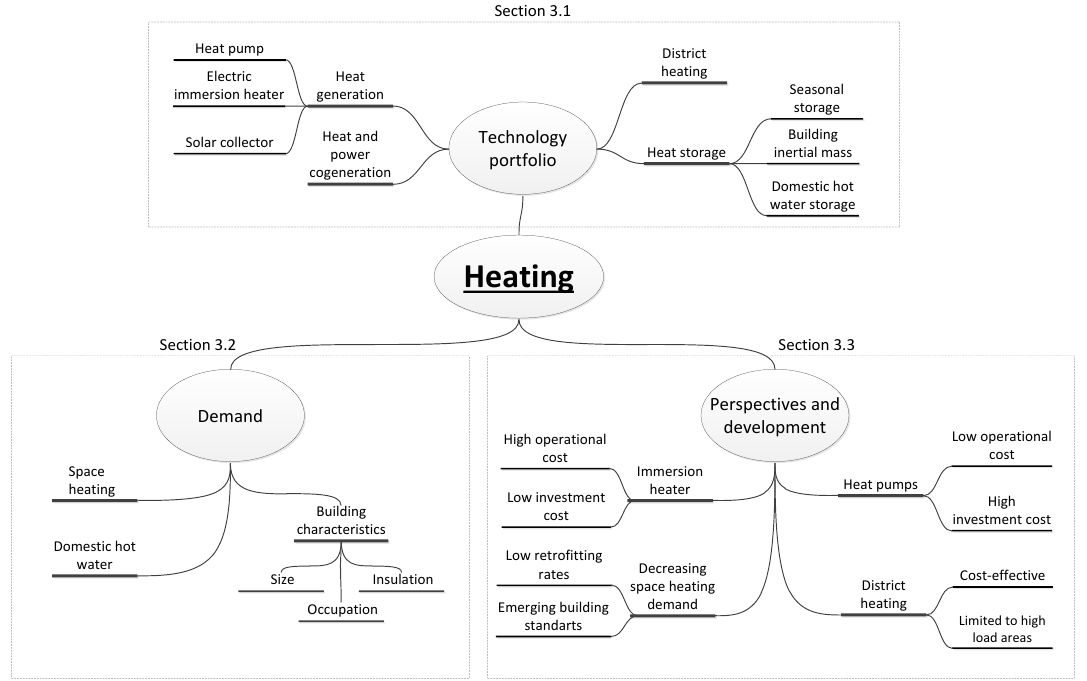
Figure 3. Overview of the heating section and the respective subsections. Section 3.1 deals with the technologies capable for heating application, Section 3.2 investigates the heating demand, and Section 3.3 describes perspectives and developments. The branches indicate considered aspects within a subsection.